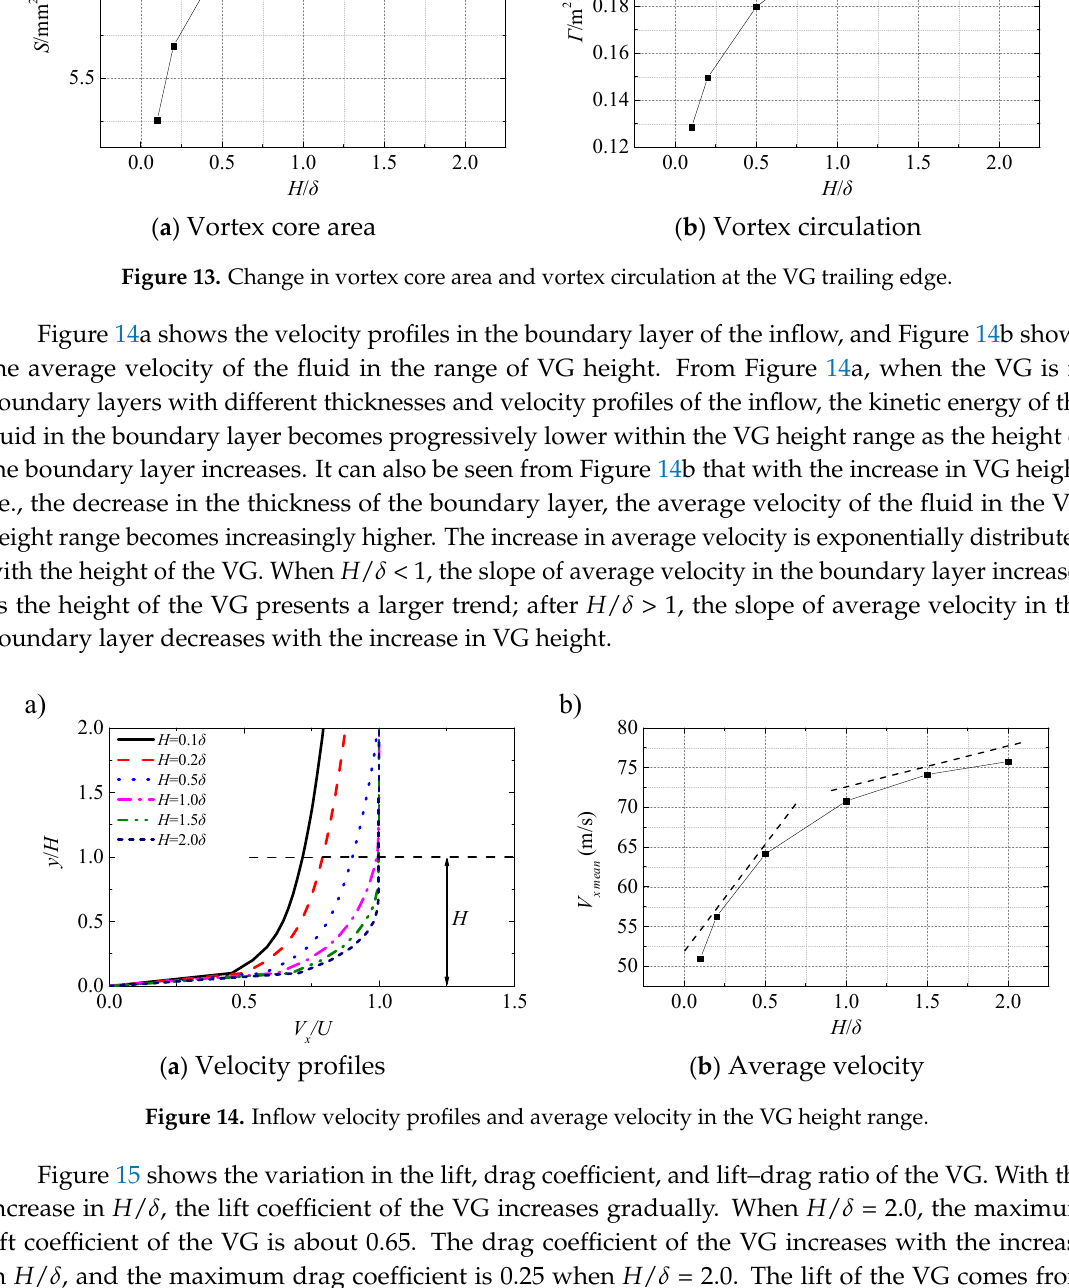
( b ) Vortex circulation Figure 12. Distribution of vortex core area and vortex circulation with flow direction. Figure 13 shows the variation in the vortex core area and vortex circulation as VG height increases at its trailing edge. It is shown that the vortex core area is the largest when H / δ = 1.0. The